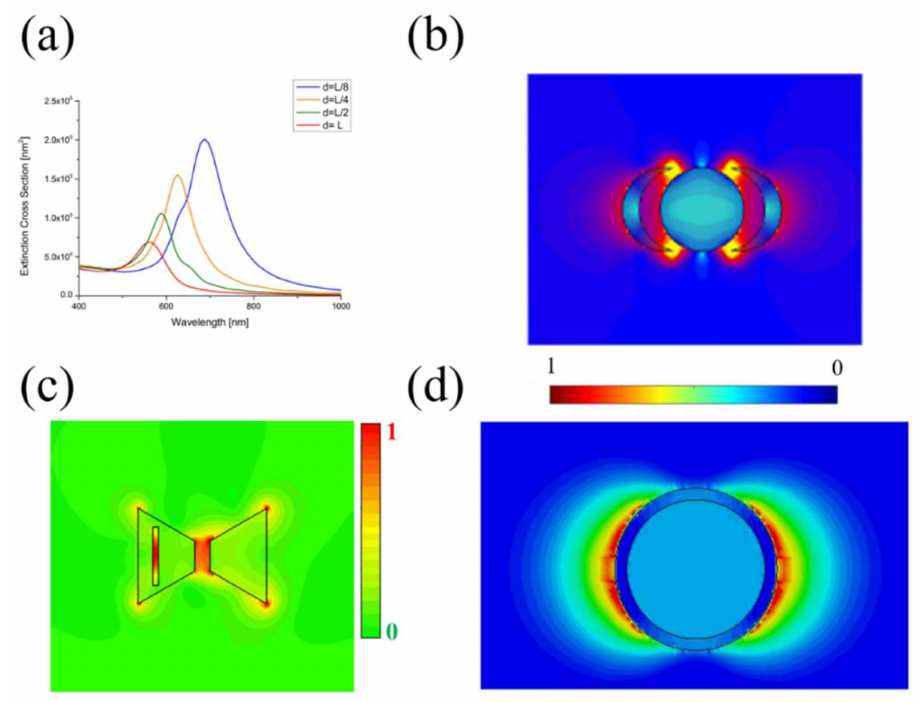
Figure 2. ( a ) Extension cross-section spectra for different inter-particle distance. Near electric field distribution for: ( b ) Multi-polar resonant structure; ( c ) Modified bow-tie particle; and ( d ) The core/shell particles at the resonant PMMA-Graphene plasma wavelength (572